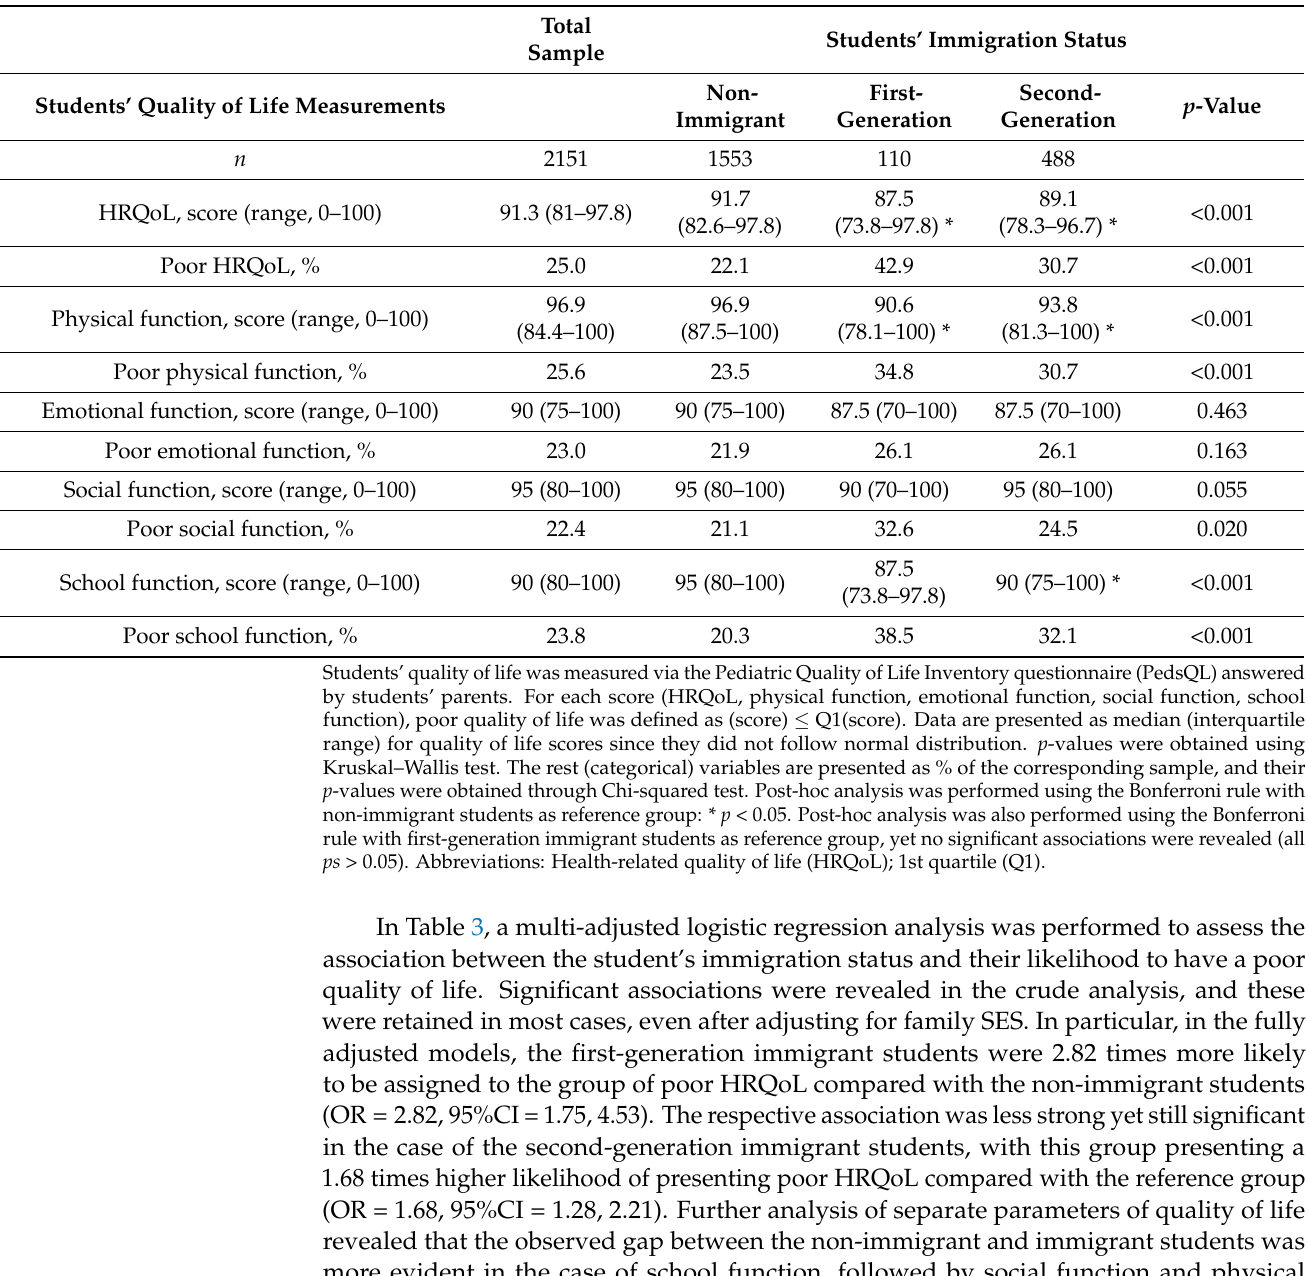
Parent-perceived quality of life measurements in students participating in the DIATROFI